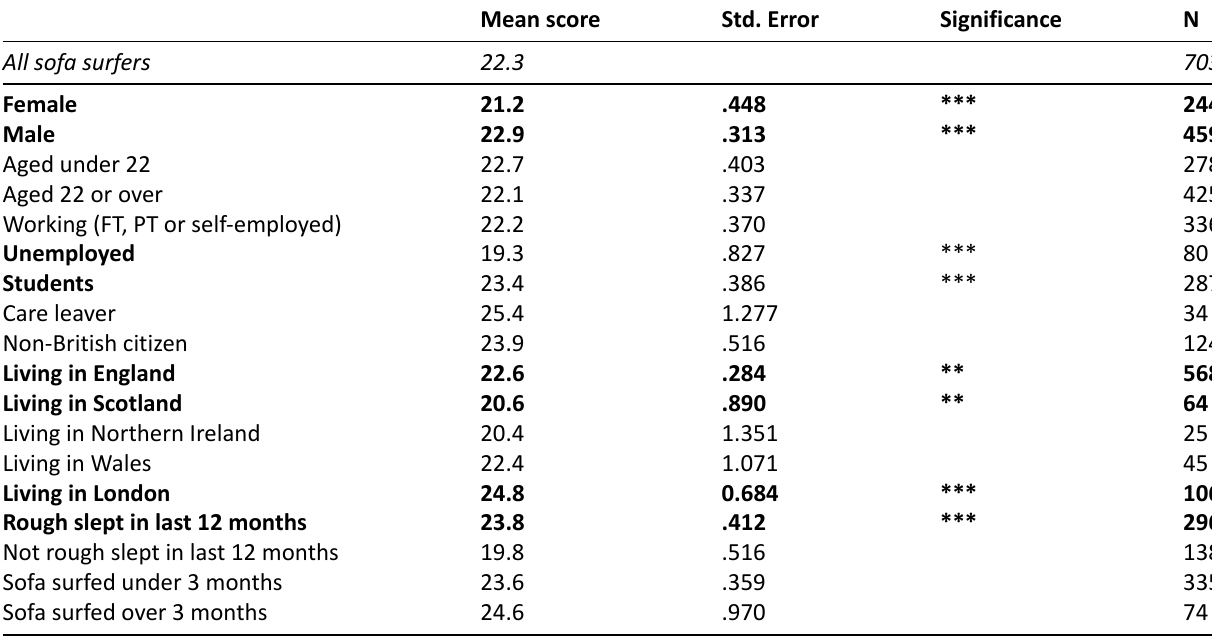
Table 8. ‘Positive rating’ for sofa surfing by demographic